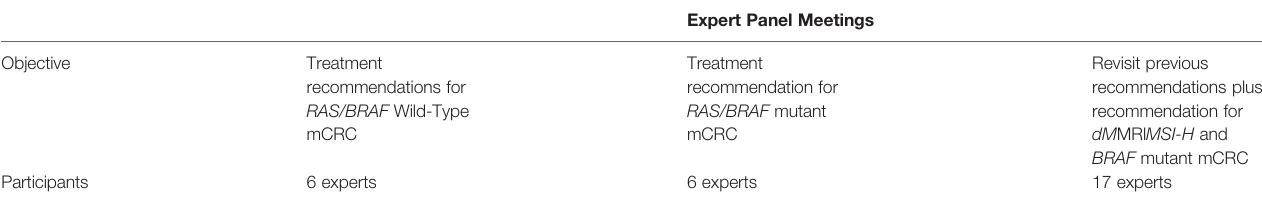
TABLE 3 | Structure and objectives of three expert panel meetings.